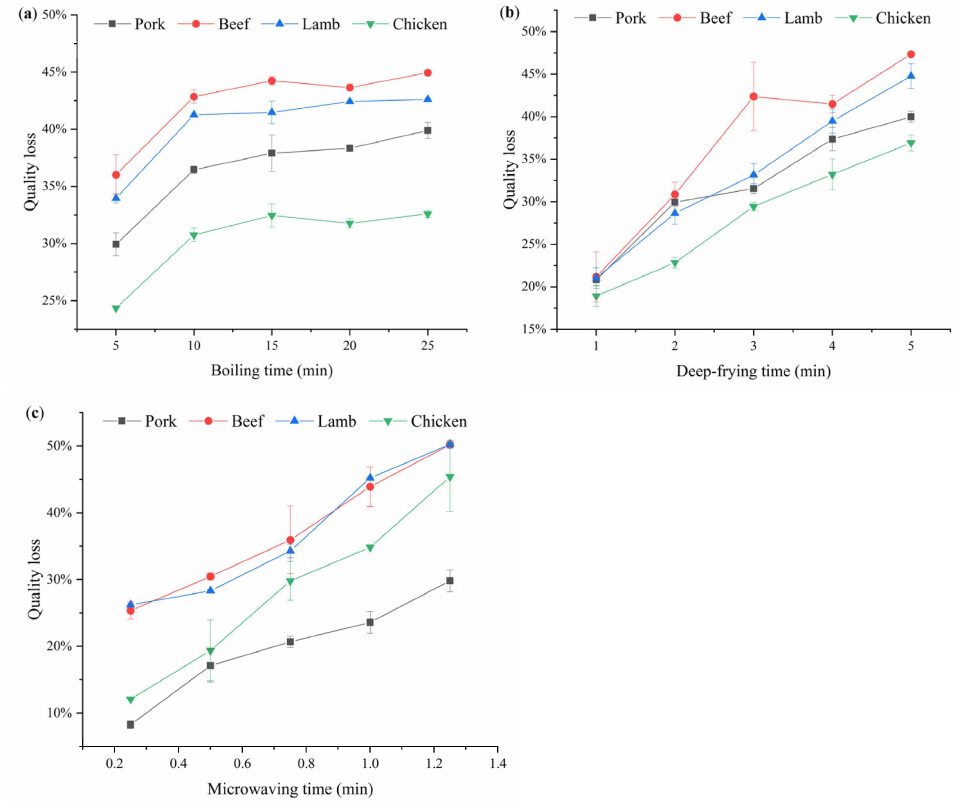
Figure 2. Processing quality loss of livestock and poultry meat. ( a ) Boiling; ( b ) Deep-frying; ( c )